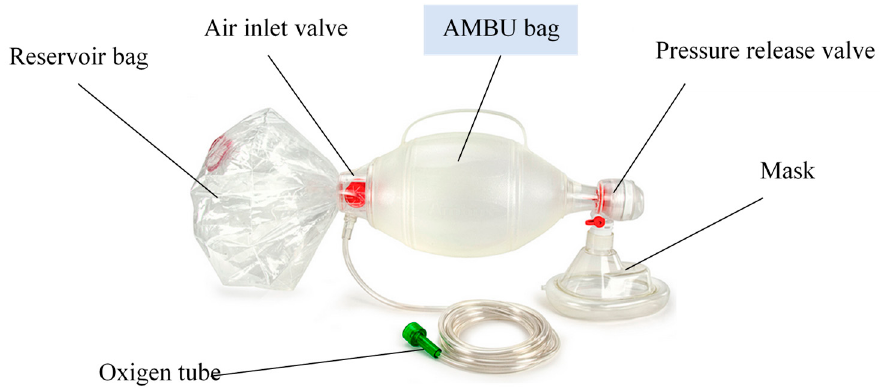
Figure 1. Standard auxiliary manual breathing unit (AMBU) bag and main accessories. The AMBU bag was originally intended to be manually compressed for emergency purposes.